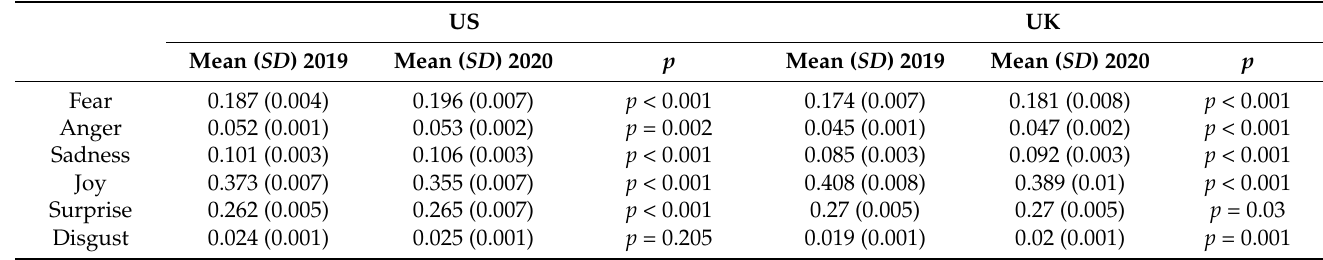
Table A3. Mean values of emotions pre- and mid-pandemic by US and UK HCPs.